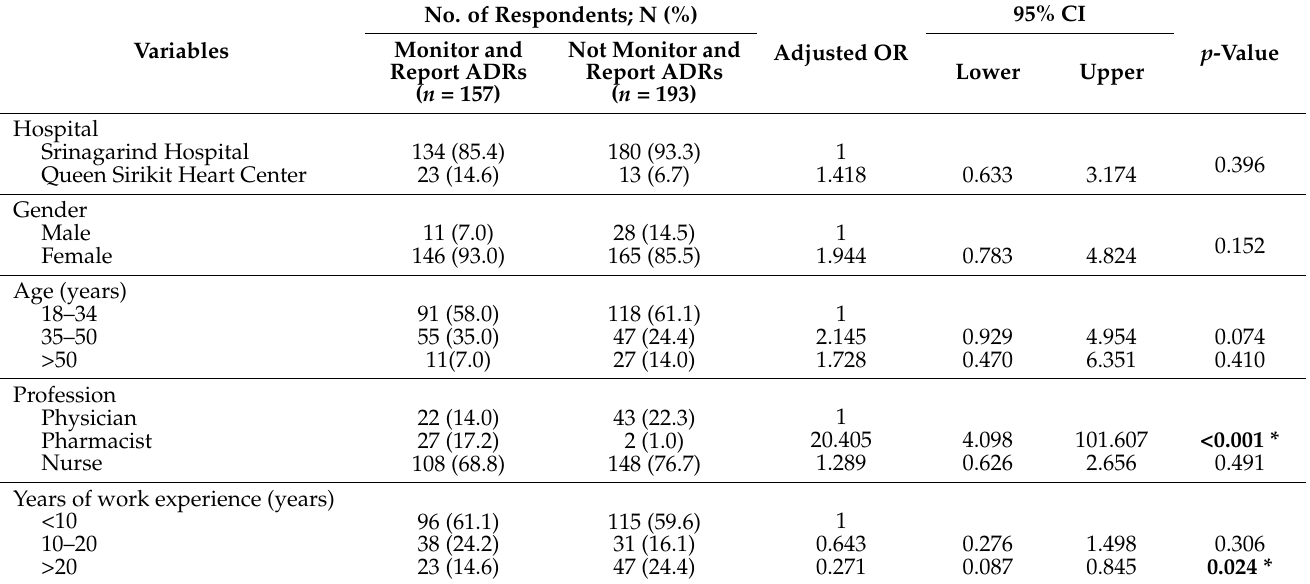
Table 4. Multiple logistic regression analysis of the factors related to practices in ADR monitoring and reporting.